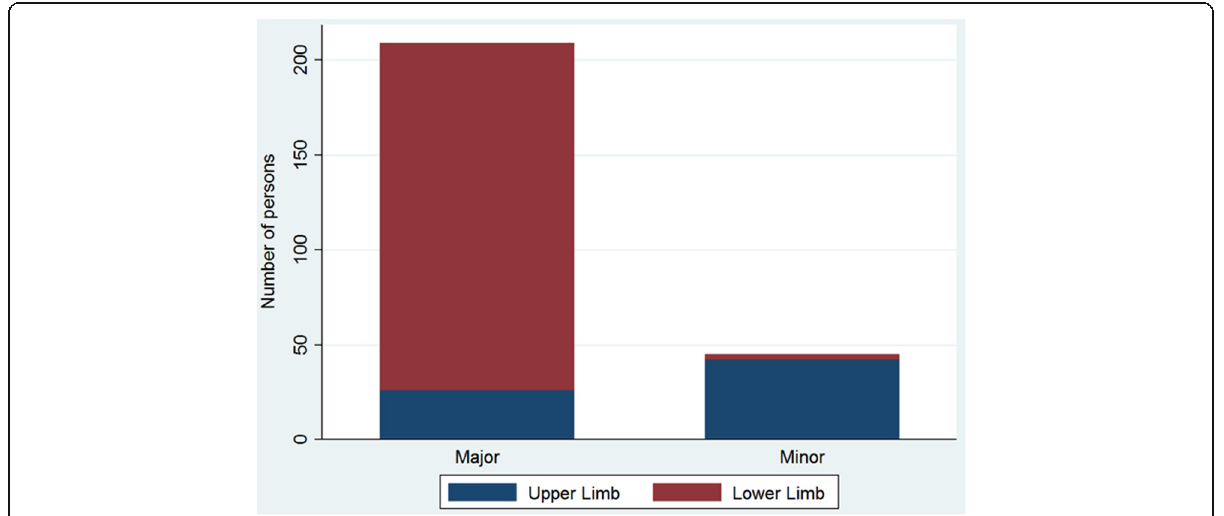
Fig. 2 Minor and major amputations by limbs ( N = 254). * N = 254. Nearly nine out of ten amputations were major amputations: 216 (85%)